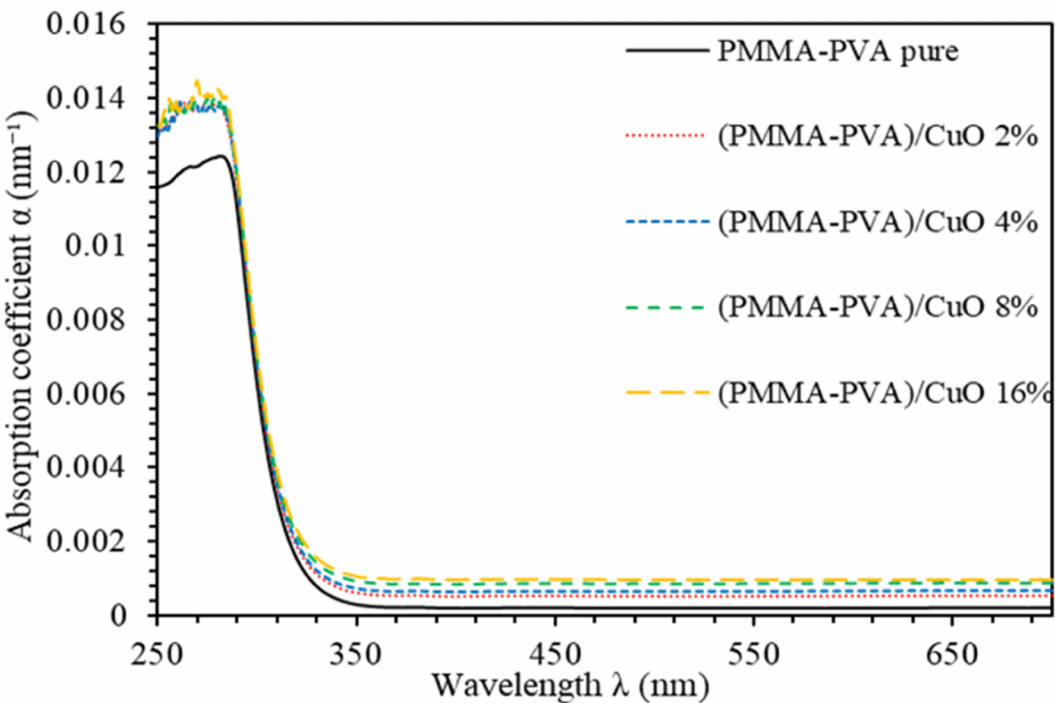
Figure 3. Absorption coefficient spectra ( α ) of PMMA–PVA/CuO nanocomposite thin films as a function of wavelength for different CuO NPs